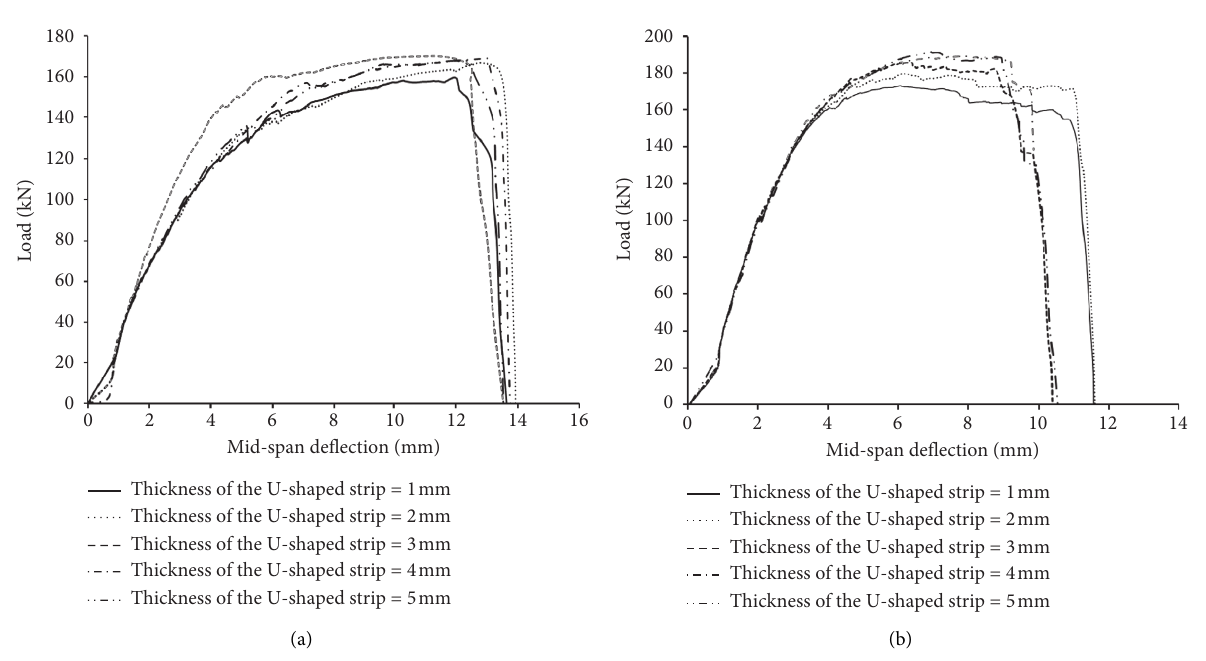
Figure 16: Load-deflection curves of the beams U10C30 and SU10C30 strengthened by the different thicknesses of U-shaped steel strip: (a) U10C30 and (b)